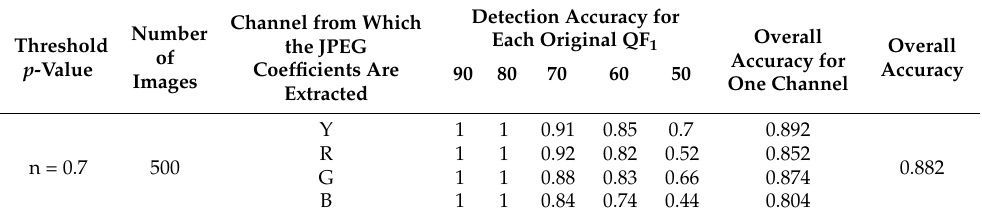
Table 7. The algorithm results using Y, R, G and B